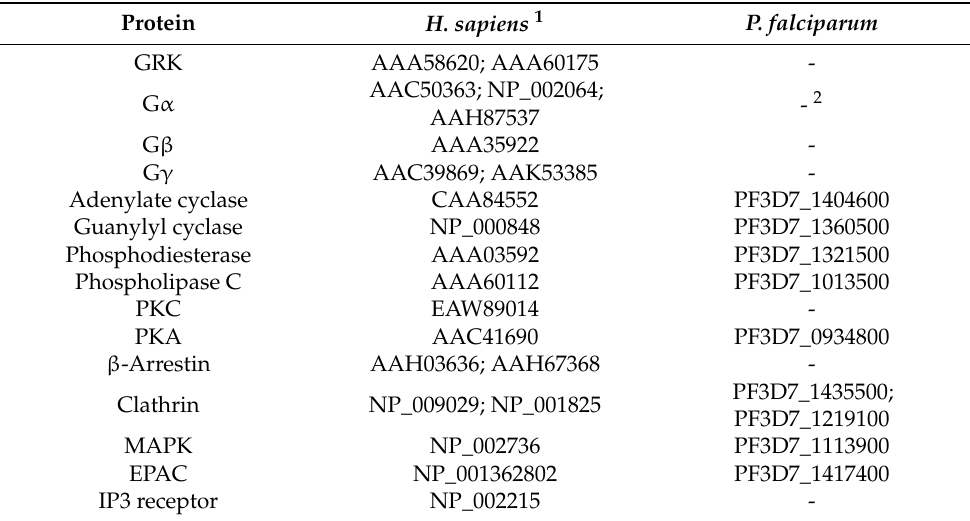
Table 1. Common representatives of a canonical GPCR signaling pathway in H. sapiens and P. falciparum